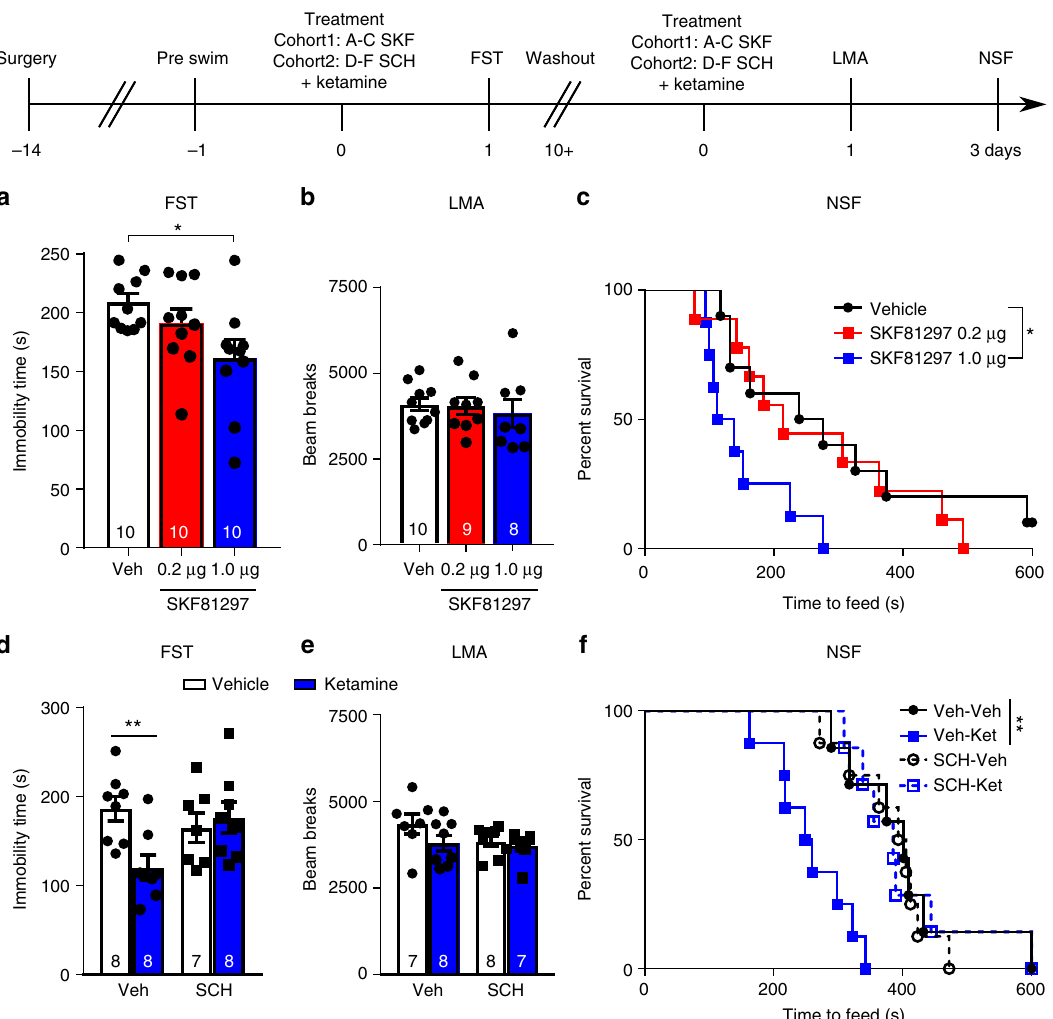
Fig. 7 mPFC D1r pharmacological manipulations impact the effects of ketamine. a FST immobility time 24 h after D1r agonist administration (ANOVA p < 0.05, post-hoc t -test p < 0.05 vs. Veh). b Locomotor activity 24 h after D1r agonist infusion. c Time to feed in the NSF test 48 h after D1r agonist infusion (Mantel – Cox (log rank) overall p < 0.05, Veh vs. 1.0 µ g p < 0.05). d FST immobility time 24 h after ketamine treatment with, or without, D1r antagonist (500 ng/side) pretreatment (Factorial ANOVA interaction p < 0.05, post-hoc t -test p < 0.01). e Locomotor activity 24 h after ketamine treatment with, or without, D1r antagonist pretreatment. f NSF time 72 h after treatment with combinations of ketamine and D1r antagonist (Mantel – Cox (log rank) overall p < 0.001, Veh – Veh vs. Veh – Ket p < 0.01); * p < 0.05, ** p < 0.01. Error bars represent mean ± SEM. All data points —